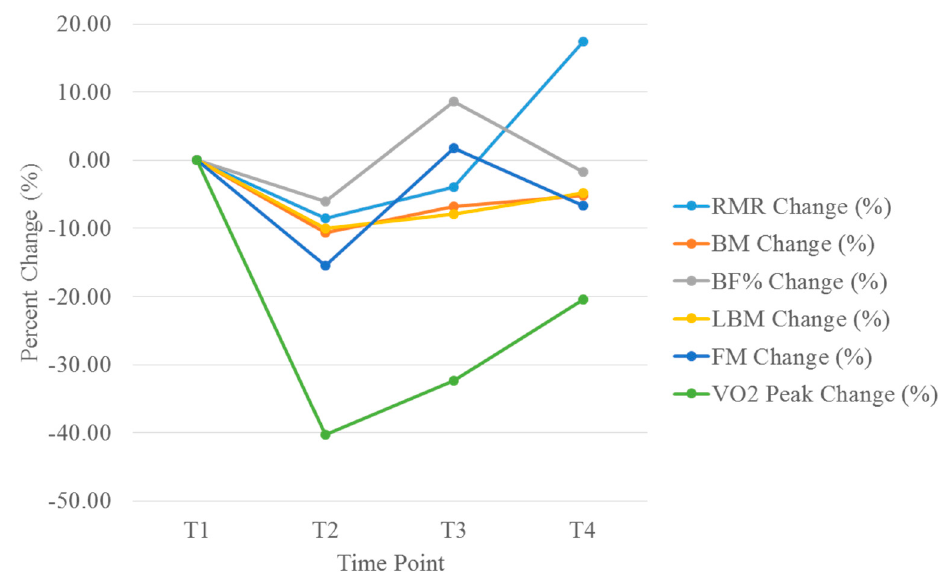
Figure 1. Changes in peak oxygen consumption (VO 2 peak), resting metabolic rate (RMR) and body composition parameters. VO 2 = volume of oxygen consumption; RMR = resting metabolic rate.